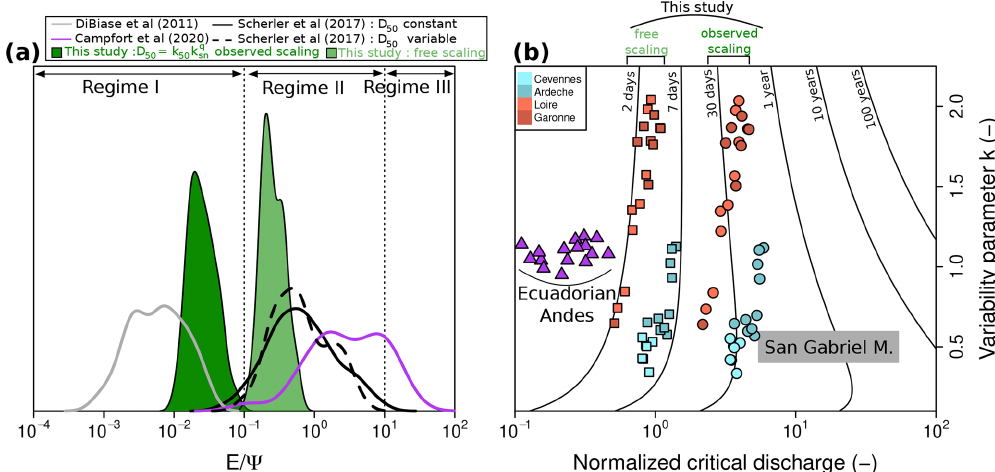
Figure 10. (a) Long-term measured erosion rate E normalized by incision threshold (cid:57) (Eq. 7), allowing for distinguishing the various regime domains discussed in Lague et al. (2005) and DiBiase and Whipple (2011). The parameters used in the calculation ( k e , τ c ) were obtained from each of the corresponding studies (DiBiase and Whipple, 2011; Scherler et al., 2017; Campforts et al., 2020). For the Ecuadorian Andes data, we use parameters listed in Campforts et al. (2020, Table 4) for their variable runoff, variability, and erodibility ST-SPM model (model 8). For the Himalayas and eastern Tibet data, we use the parameters listed in Scherler et al. (2017, Table 5) for their “Himalaya and eastern Tibet TRMM models”, with either constant D 50 and constant τ ∗ c (solid black line) or variable D 50 and constant τ ∗ c (dashed black line). Dark and light green curves correspond to our sampled basins with observed (Fig. 7d) and free (Fig. 7f) D 50 scaling (Eq. 13), respectively. (b) Plot of the discharge variability parameter k against normalized critical discharge Q ∗ c calculated from Eq. (11). Black lines correspond to the return time of normalized critical discharge t r ( Q ∗ c ) calculated from Eq. (17) (Lague et al., 2005; Lague, 2014). Purple triangles and grey rectangles correspond to DiBiase and Whipple (2011) and Campforts et al. (2020) results, respectively, with the same model parameters as in the previous panel. Circles and squares correspond to our results with observed and free D 50 scalings, respectively. The results from Scherler et al. (2017) were not plotted here, as they use a different definition of the discharge probability